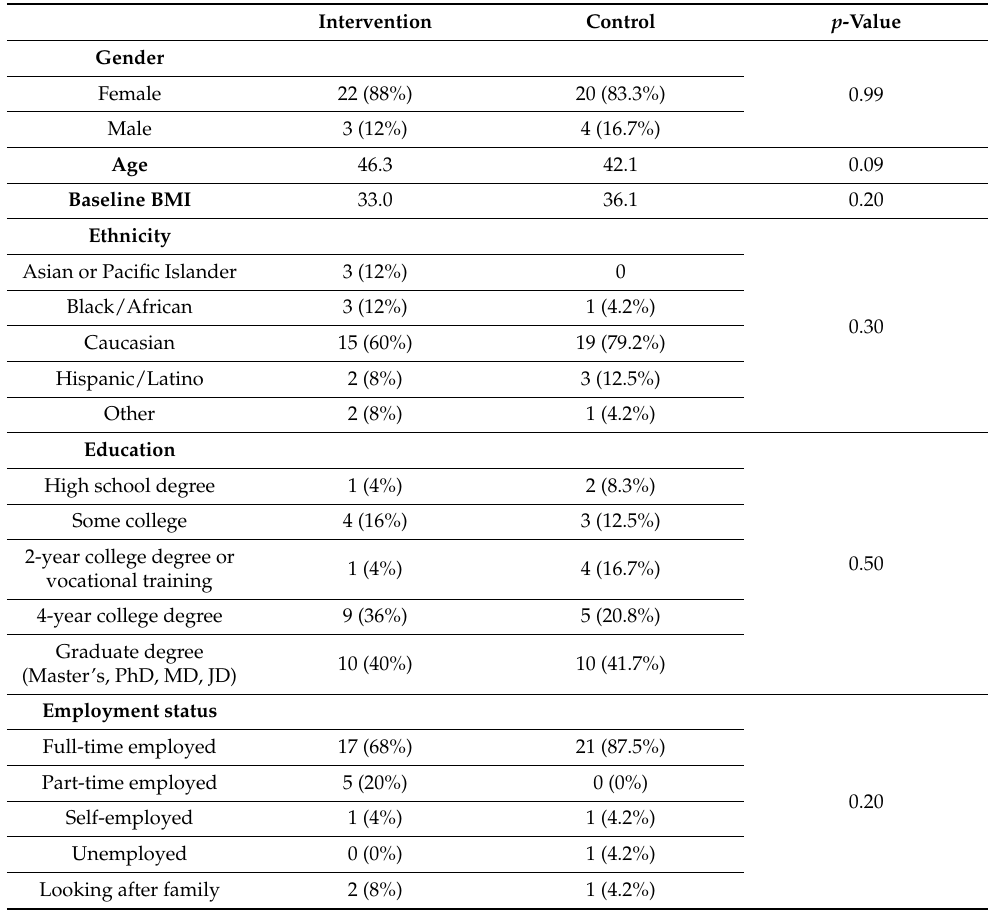
Table 1. Demographics and baseline characteristics.